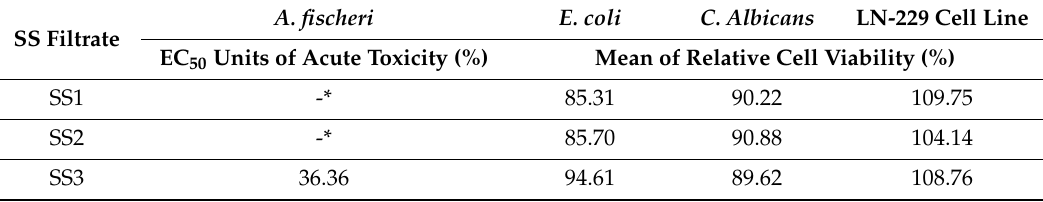
Table 4. Results of cytotoxicity analysis obtained by using di ff erent biological models. SS